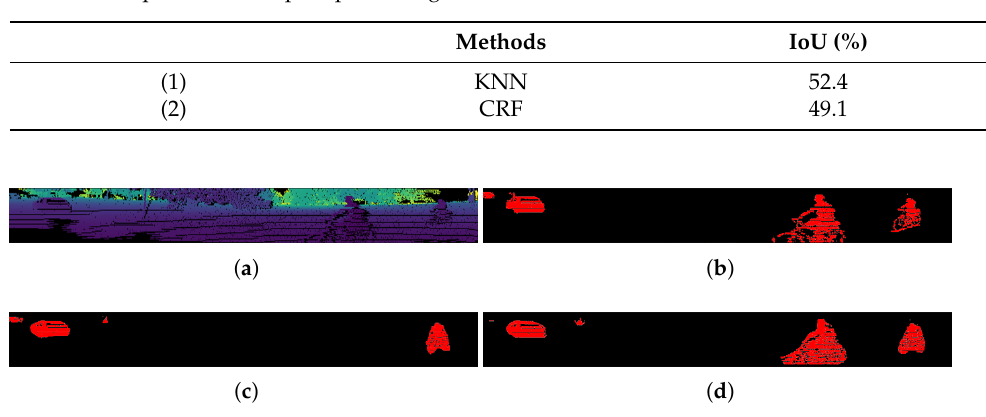
Table 4. Comparison of the post-processing between the KNN and the CRF on the validation set.